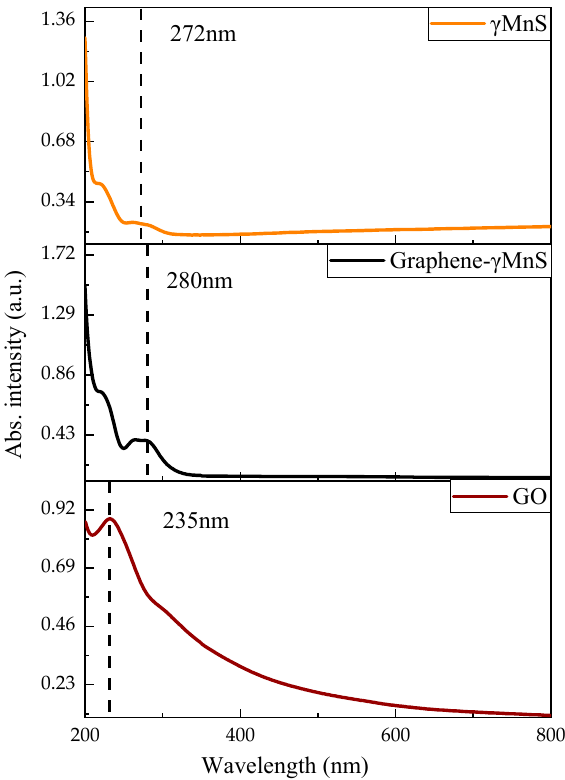
Figure 6. UV-vis absorption spectra of GO, γ MnS, and graphene- γ MnS.